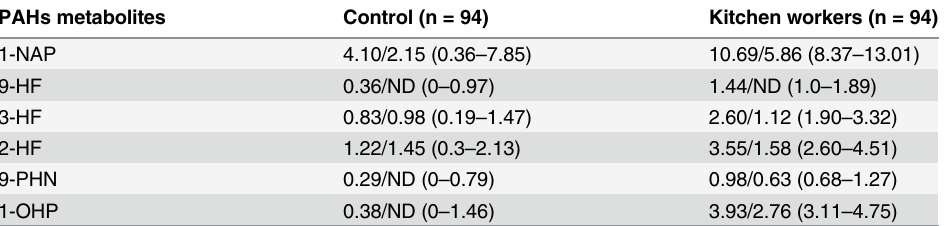
Table 5. Concentration of Urinary PAHs metabolite in creatinine adjusted urine samples (ng/ml) in study subjects. PAHs